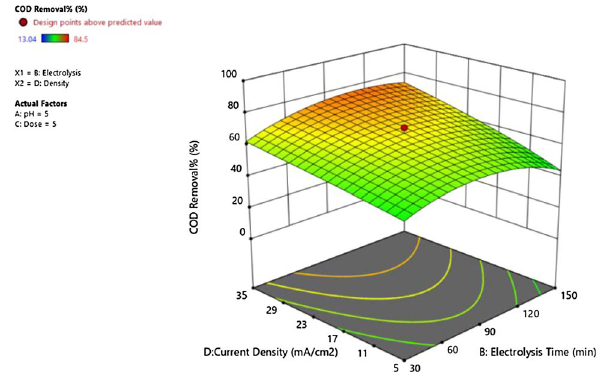
Fig. 9 3D surface plot of the graph represents the interaction of elec- trolysis time and current density with respect to the COD %